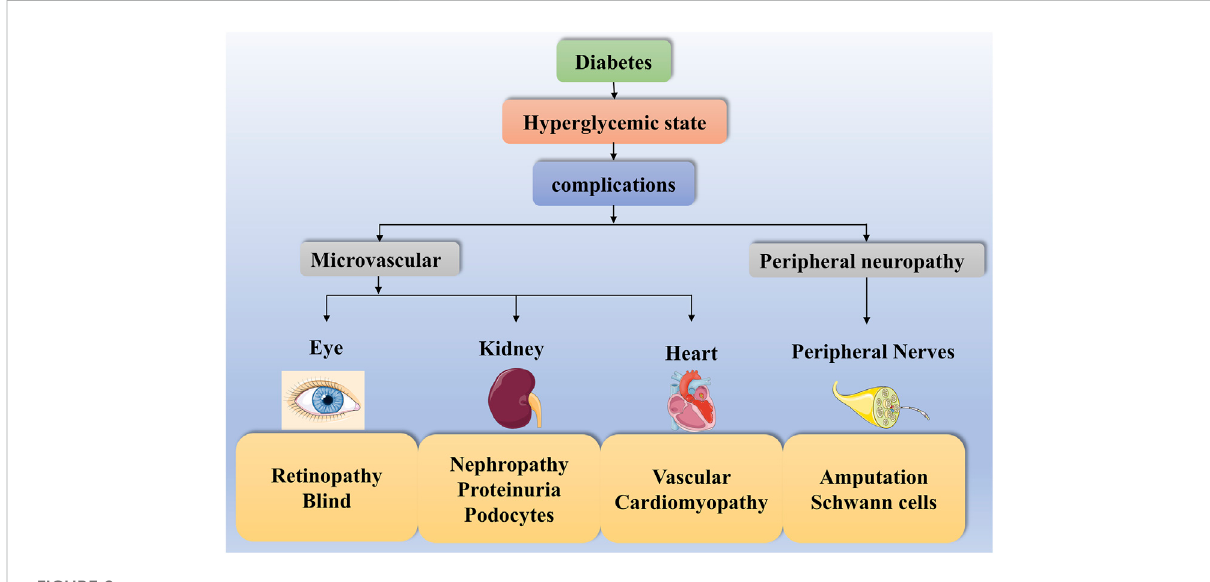
FIGURE 2 Diabetes complications. The high-glucose state of diabetes can contribute to diverse complications such as diabetic microangiopathy and peripheral neuropathy. Some of these diabetic microangiopathies involve retinopathy, nephropathy and heart disease, such as Retinopathy, Blind, Nephropathy, Proteinuria, Podocytes, Vascular and Cardiomyopathy. In contrast, peripheral neuropathy presents with Amputation and Schwann